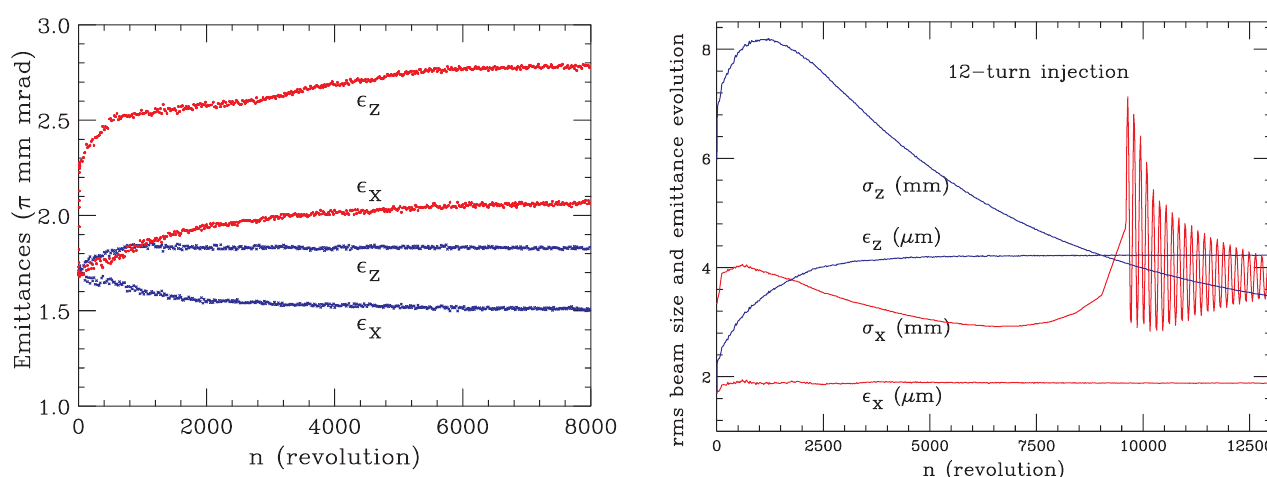
FIG. 36. (Color) The emittance evolution for a beam with 12- turn injection when the space-charge force is